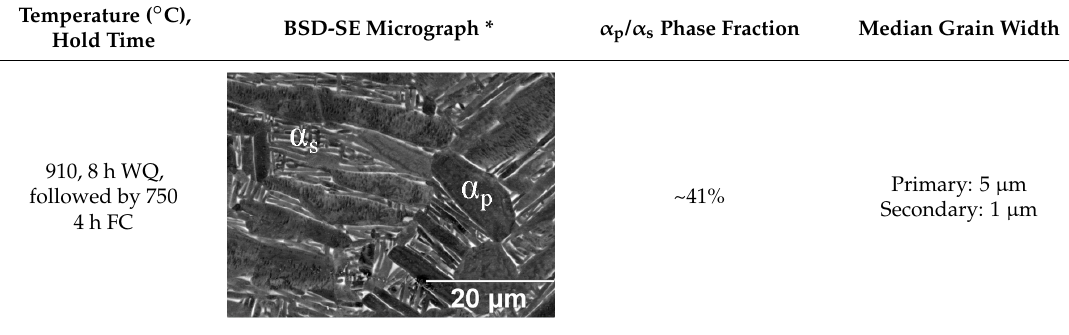
Table 8. Bi-modal microstructure summary.